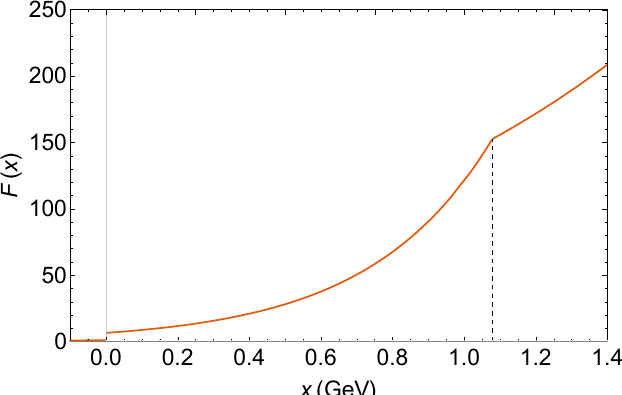
Figure 2. The function F ( x ) of Equation(10) (solid curve) with x → x + µ as required by the boundary conditions, and a singularity at the origin. F ( x ) contains the integral over an initial nonequilibrium gluon distribution n i ( x ) according to Equation(14). The parameters are given in the